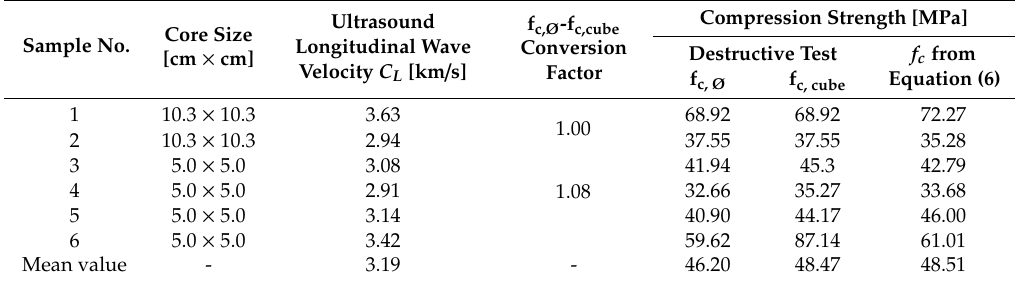
Table 2. Results of uniaxial destructive tests, measured pulse velocities and strength values calculated with use of the chosen hypothetical scaling curve. Sample